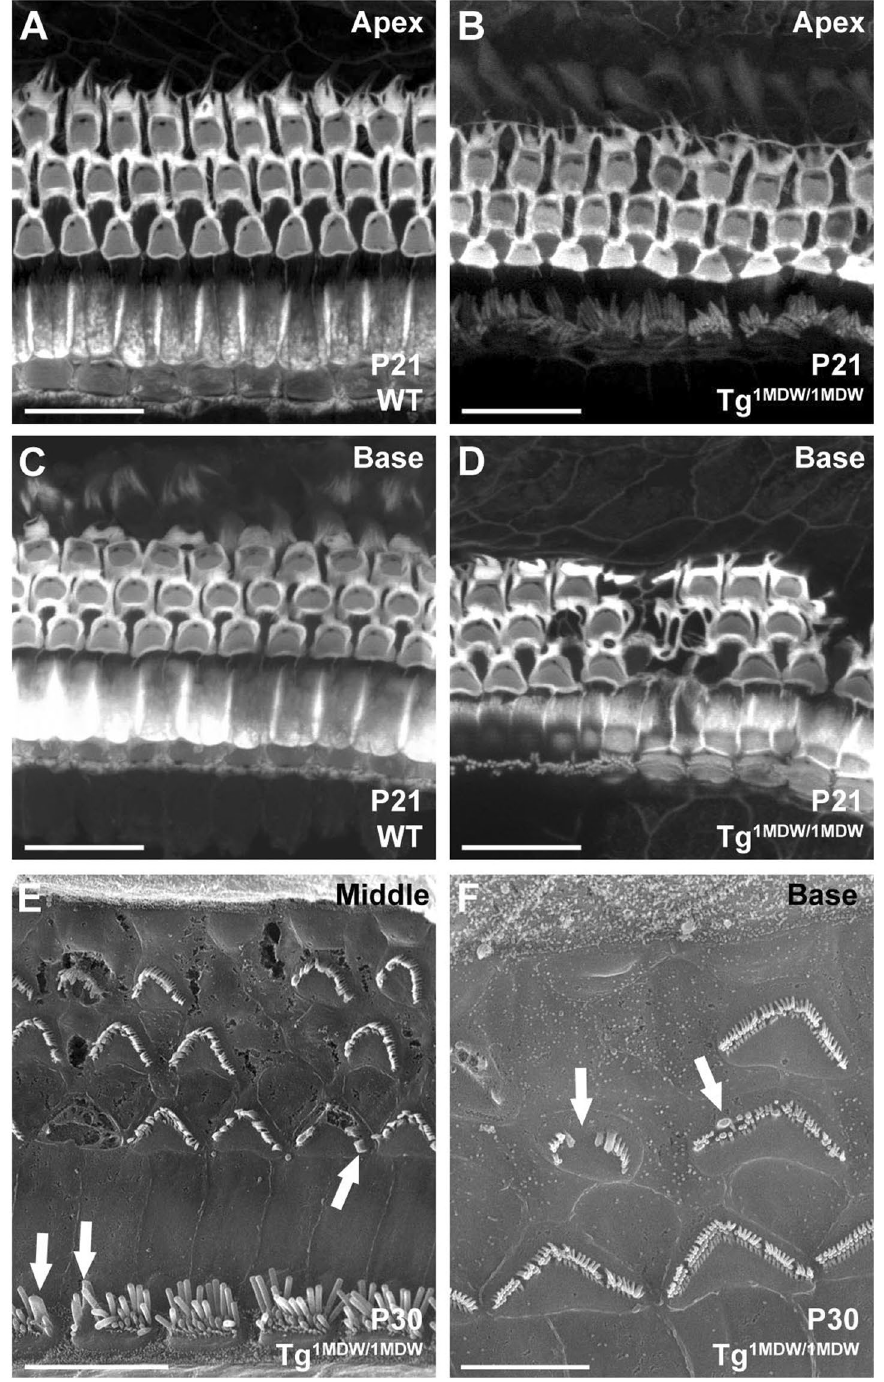
Figure 7. Tg 1MDW/1MDW OHC loss and stereocilia defects. ( A – D ) Confocal microscopy of MTRITC-Phalloidin- stained P21 WT and Tg 1MDW/1MDW cochlear tissue whole mounts. The images are brightest point projections of 7.6 micron Z-plane images parallel to the reticular lamina. ( A , B ) Apical OC shows comparable OHC/SC F-actin cytoarchitecture in WT versus Tg 1MDW/1MDW at P21. ( C , D ) In the basal OC, F-actin cytoarchitecture is disturbed due to missing OHCs in Tg 1MDW/1MDW at P21. ( E , F ) SEM images of Tg 1MDW/1MDW OC reticular lamina at P30 showing stereocilia defects in both OHC and IHCs, including absence of stereocilia and stereocilia fusion (arrows). Scale bar; 20 μ M ( A – D ), 10 μ M ( E ), 5 μ M ( F